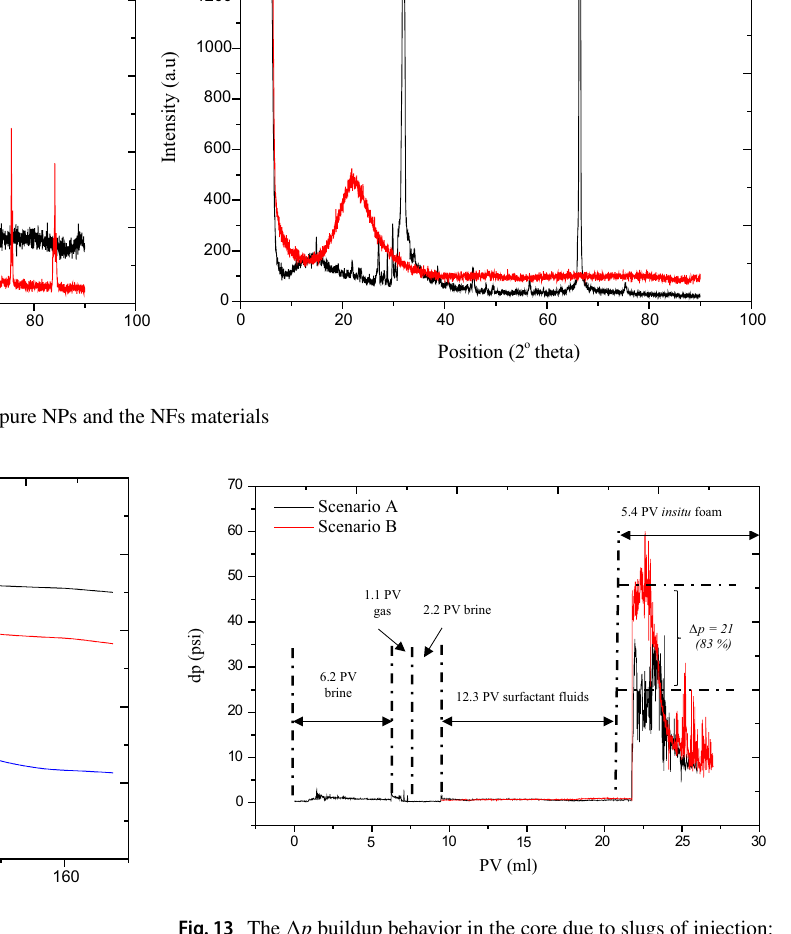
Fig. 12 The thermogravimetric stability of the NFs in comparison with the base case MFomax